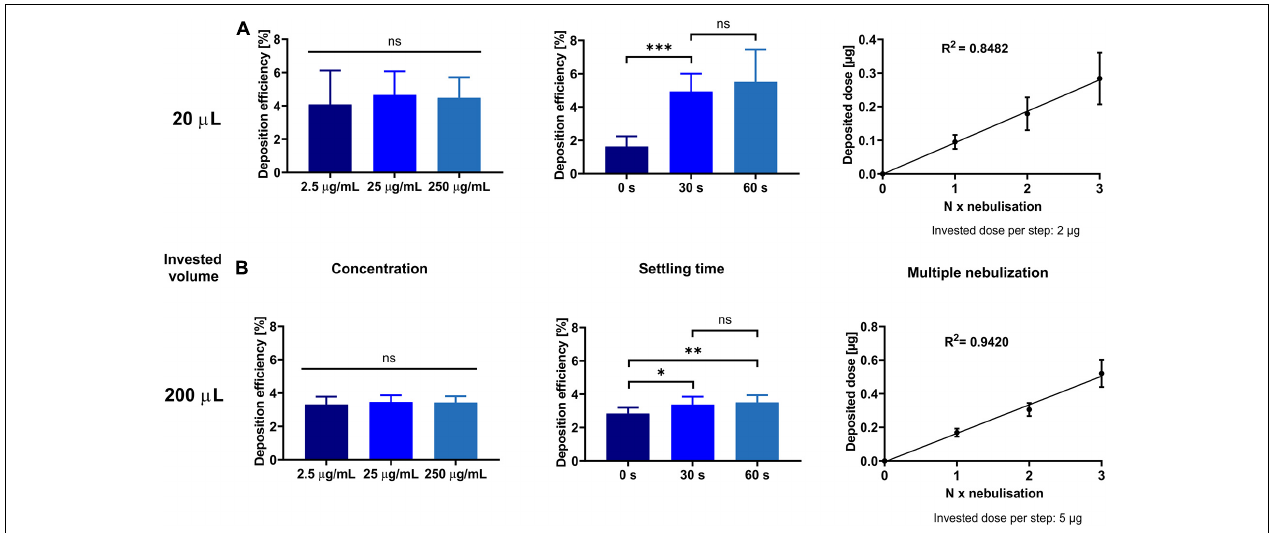
FIGURE 2 | Deposition characteristics at different concentrations, settling time, and multiple nebulization steps. Sodium fluorescein solution is deposited as described in the section “Materials and Methods.” Either 20 µ l (A) or 200 µ l (B) was used for nebulization. From left to right, 10-fold increasing concentrations were nebulized, the efficiency of different settling times after the end of nebulization processes was assessed, and respective doses nebulized one or more times into one well at 30-s settling time were analyzed, as indicated. Error bars show standard deviation. One-way ANOVA, Tukey’s multiple comparisons test, ns p > 0.12; ∗ p < 0.033; ∗∗ p < 0.002; ∗∗∗ p < 0.001. N = 9 of three experiments.